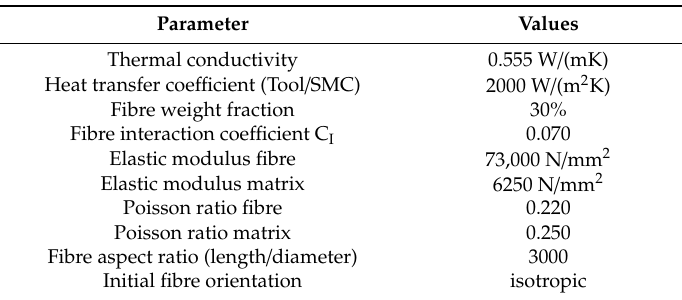
Table 1. Material parameters of SMC0400 [59].